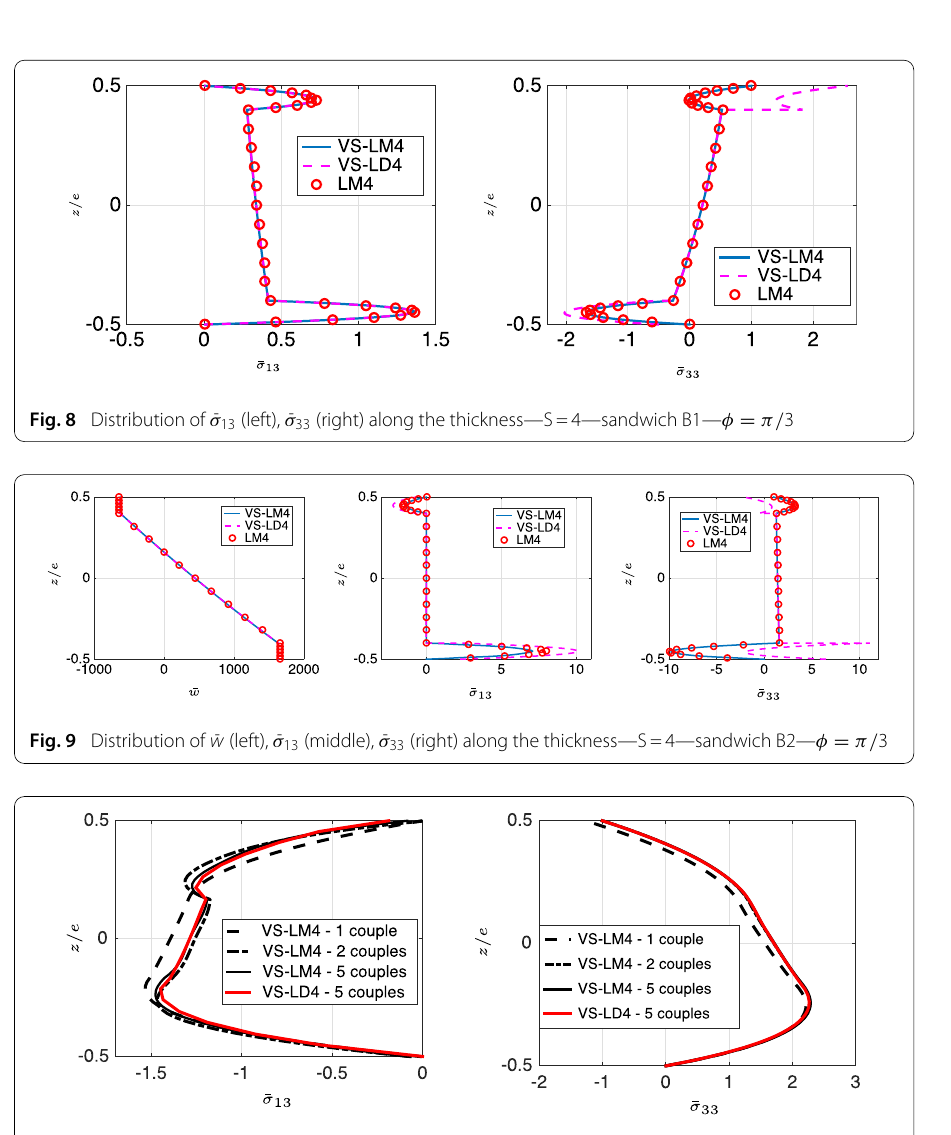
Fig. 10 Distribution of ¯ σ 13 (left), ¯ σ 33 (right) along the thickness—S=4—three layers— φ = π/ 2—constant